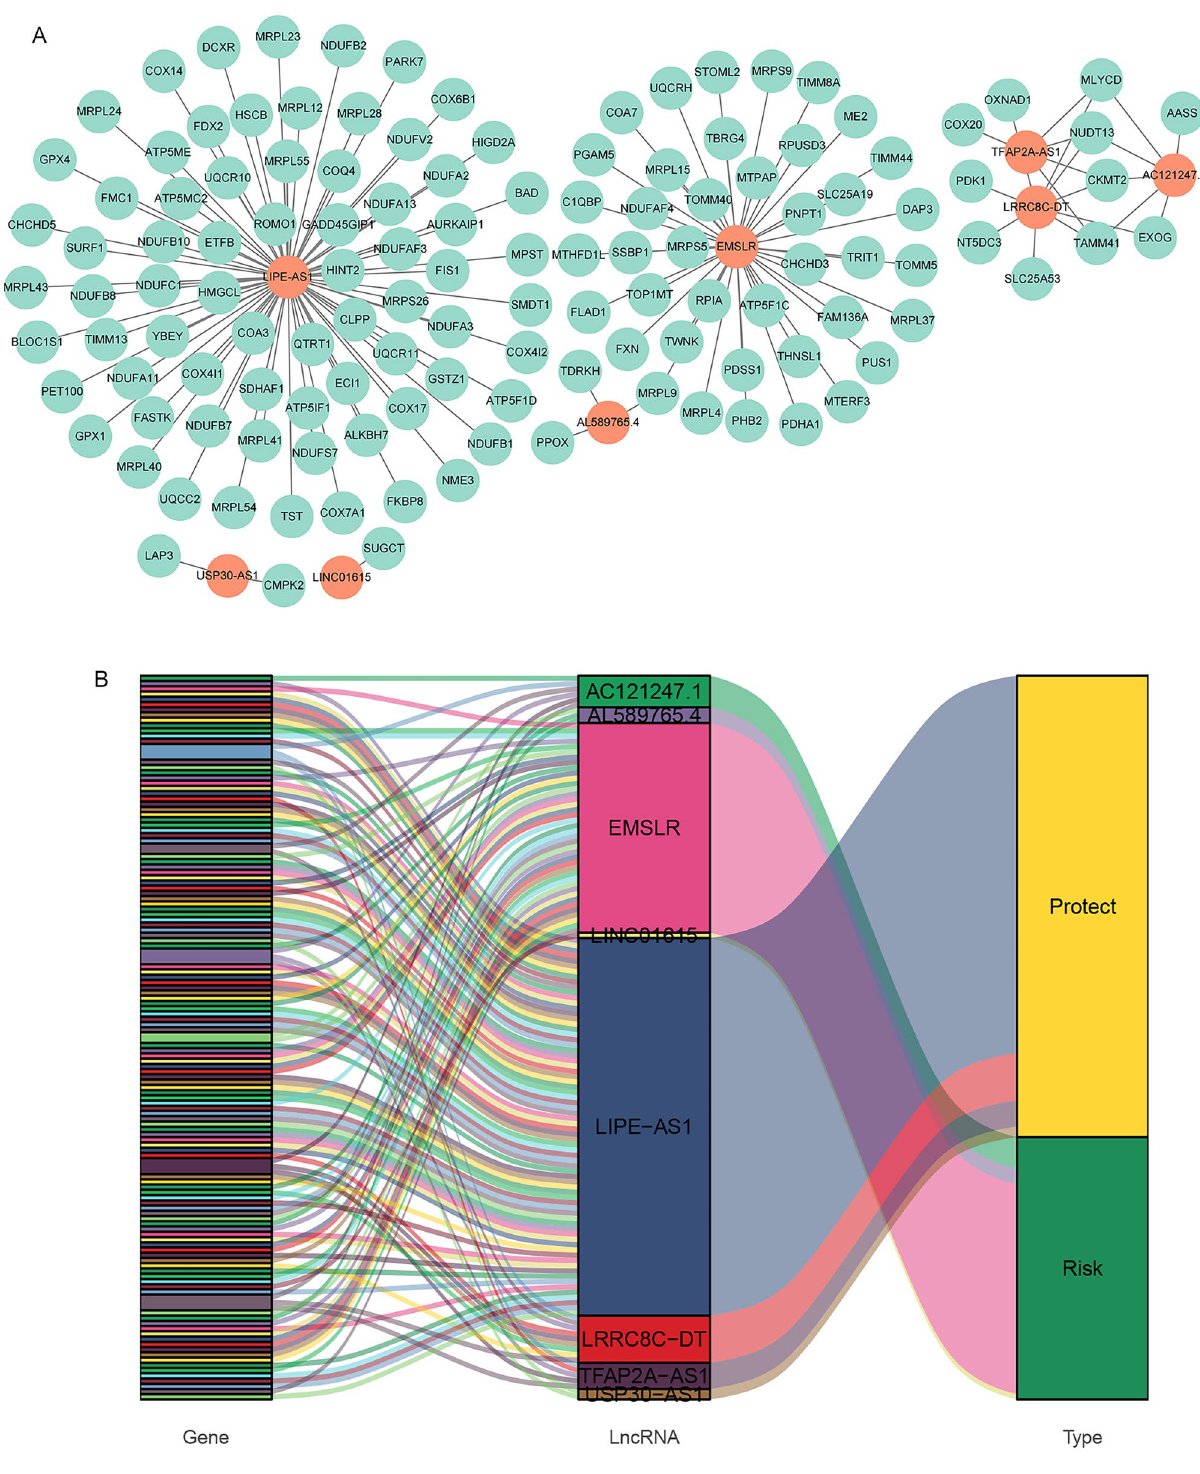
Figure 6. Construction of the mitochondrial function-related lncRNA-mRNA co-expression network. ( A ) Diagram of the mitochondrial function-related lncRNA-mRNA network. ( B ) Sankey diagram shows the connection degree between the mitochondrial function-related lncRNAs and the mitochondrial function- related